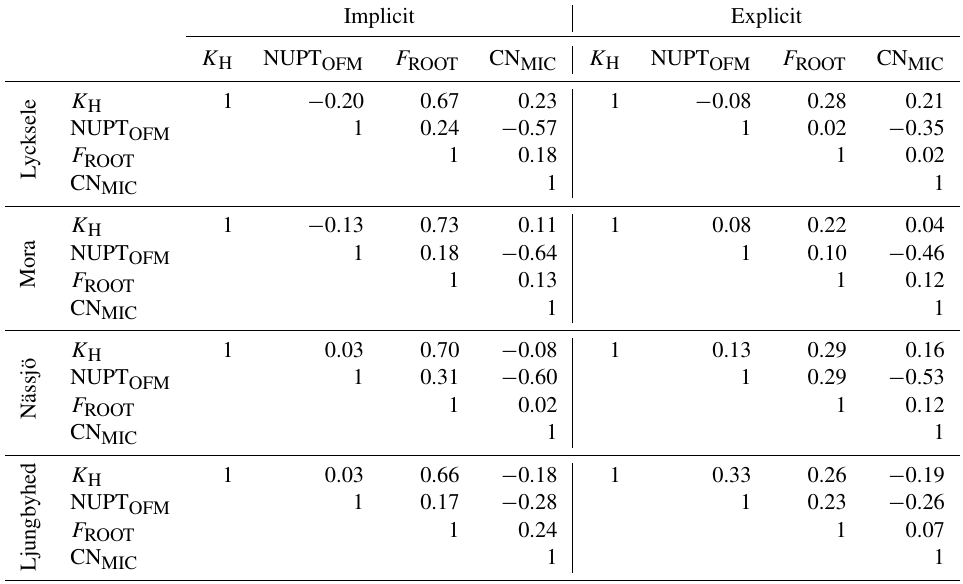
Table A2. Correlation between common model parameters for all simulated sites with the implicit and explicit approaches. Correlation is given as the Pearson correlation